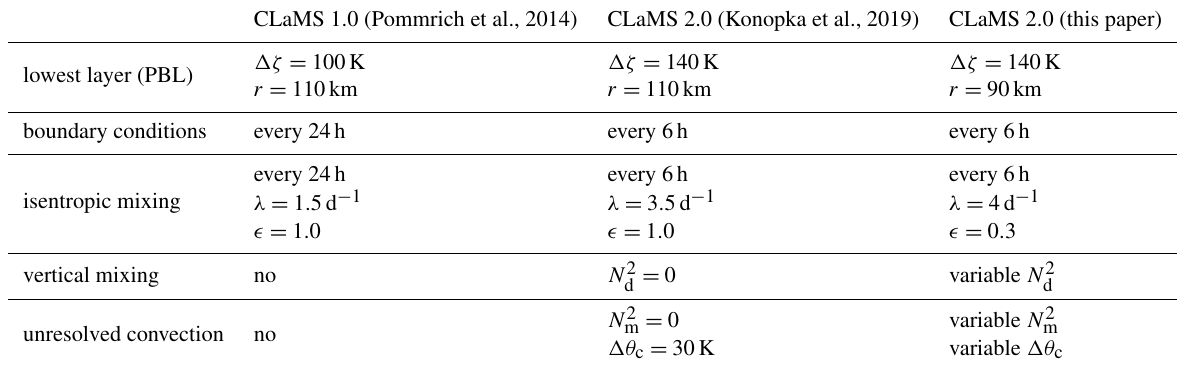
Table 1. Changes between CLaMS 1.0 (first column), CLaMS 2.0 (second column), and CLaMS 2.0 version used in this paper (third column, for details see